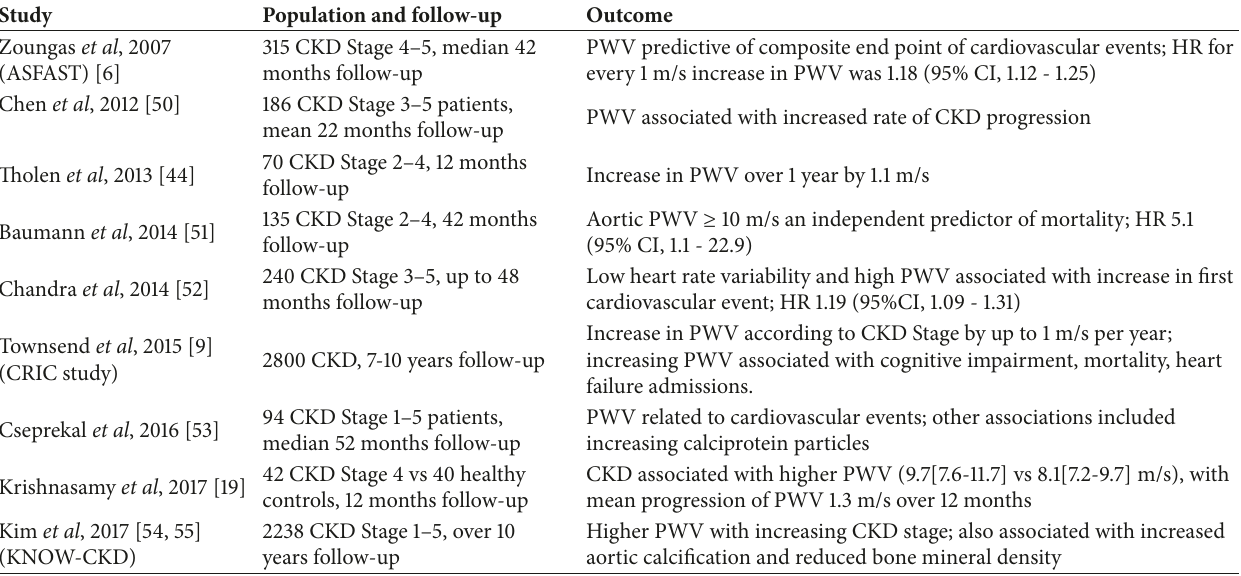
Table 1: Prospective observational studies assessing PWV in patients with